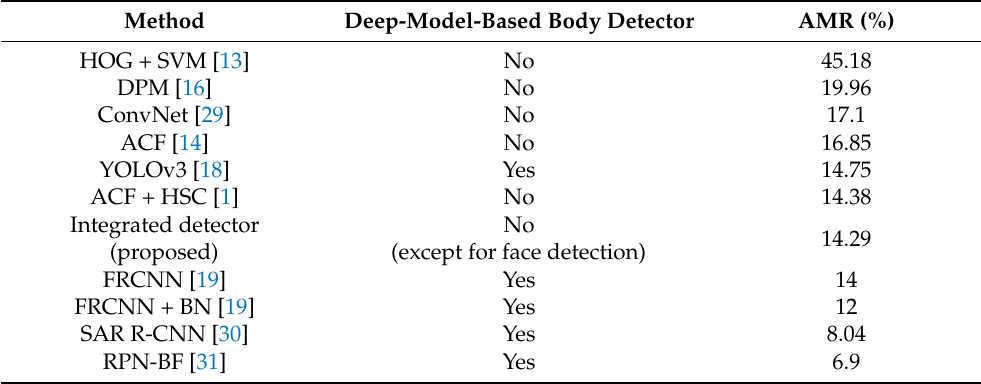
Table 8. Comparison of the AMRs of state-of-the-art detectors based on handcrafted features and deep models to the proposed detector for the INRIA test set.